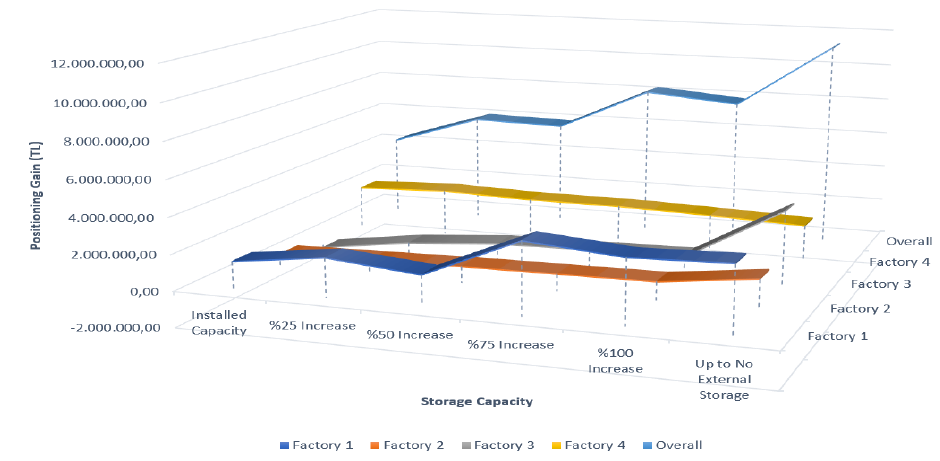
Figure 5. In-house storage capacity increase vs. positioning gain increase